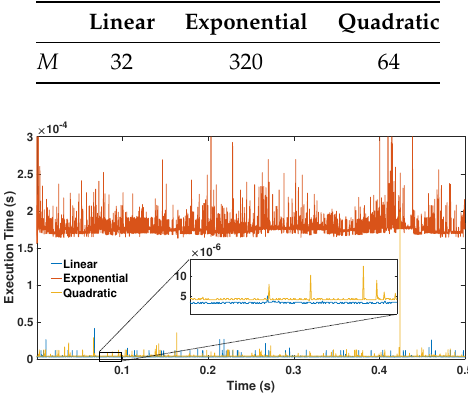
Figure 5. Execution time